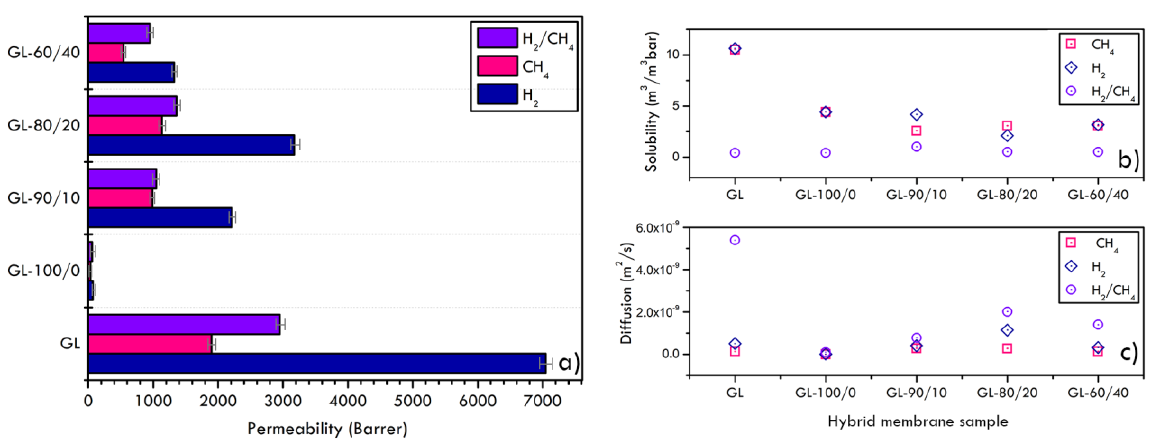
Figure 9. Permeability ( a ), solubility ( b ) and diffusion ( c ) coefficients of pure and mixed gases over investigated membranes. Table 3 . Membrane characteristics: diffusion and solubility coefficients.